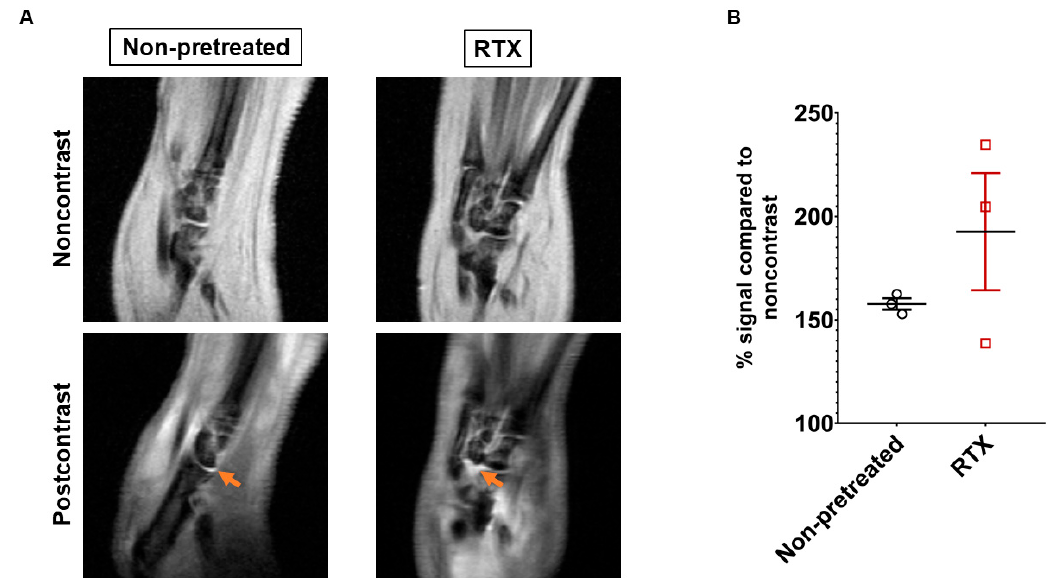
Figure 7. In vivo contrast enhanced T1-weighted MRI of the inflamed ankle joints on day 5. ( A ) Representative images pre- and postcontrast (iv. gadolinium). Increased synovial signal highlighted by arrows on the postcontrast images. ( B ) Quantitative evaluation of intraarticular signal intensity after the contrast agent ( n = 3/group right hindlimb, unpaired t test).